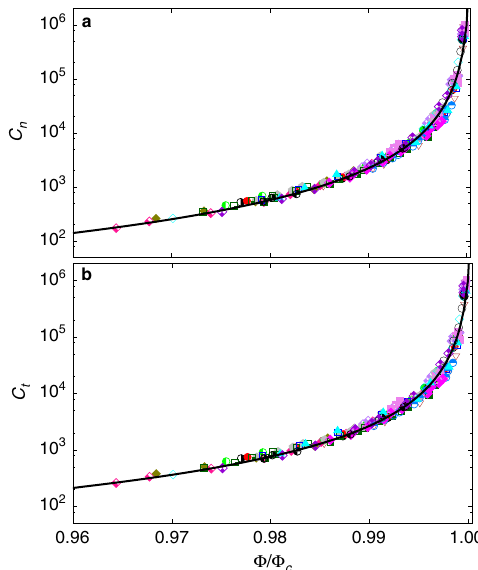
Fig. 4 Effective viscosities in the NVT ensemble. Normalized bulk viscosity c n ( a ) and shear viscosity c t ( b ) as a function of the normalized packing fraction Φ ∕ Φ c , where Φ c is the quasistatic packing fraction depending linearly on the cohesion index; see Eq. (5). The error bars represent the standard variation over steady-state fl ow, and the symbols and their colors are the same as those in Fig. 2. The solid lines are the functional forms of Eq. (8) and Eq. (9),